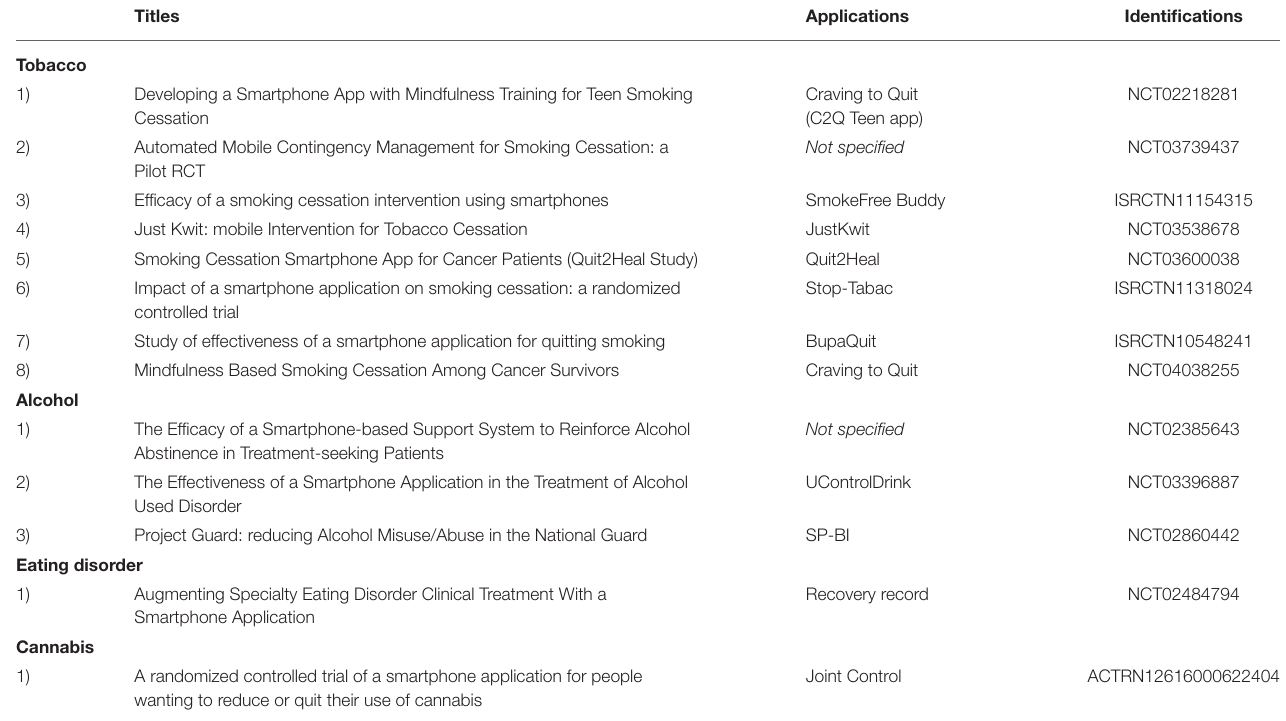
TABLE 6 | Studies in progress or waiting for publication on Clinical